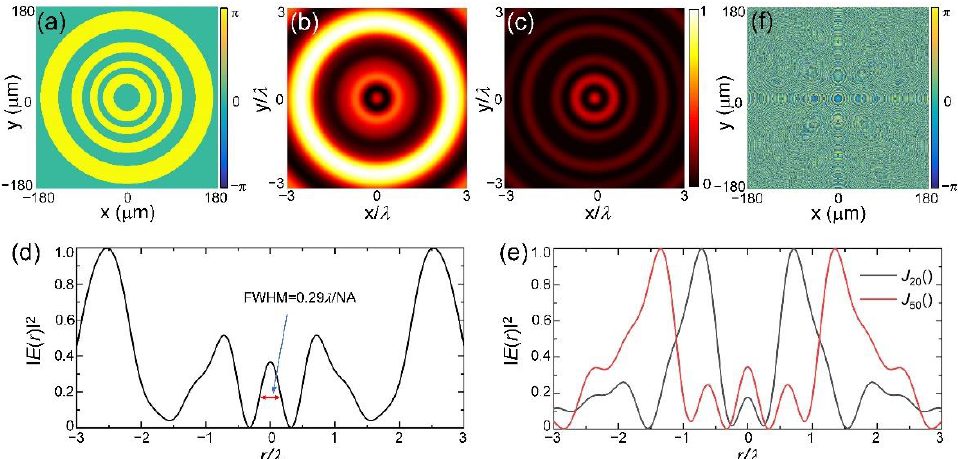
Figure 2. Generation of superoscillatory focal field from the tightly focusing of vector light field. ( a ) Binary phase of the diffractive optical element designed from angular Bessel function with k r = 0.43 k and NA = 0.9; ( b ) Simulated total intensity distribution of the focal field; ( c ) The intensity distribution of the longitudinal component I z at the focal plane; ( d ) Intensity distribution along the radial direction. ( e ) Intensity distributions of focal fields corresponding to the metalens designed from 20th and 50th order Bessel functions of the first kind with k r = 0.68 k 0 and 0.66 k 0 , respectively; ( f ) Modulation phase of the metalens generated from the combination of tightly focusing phase and binary phase in 2a.